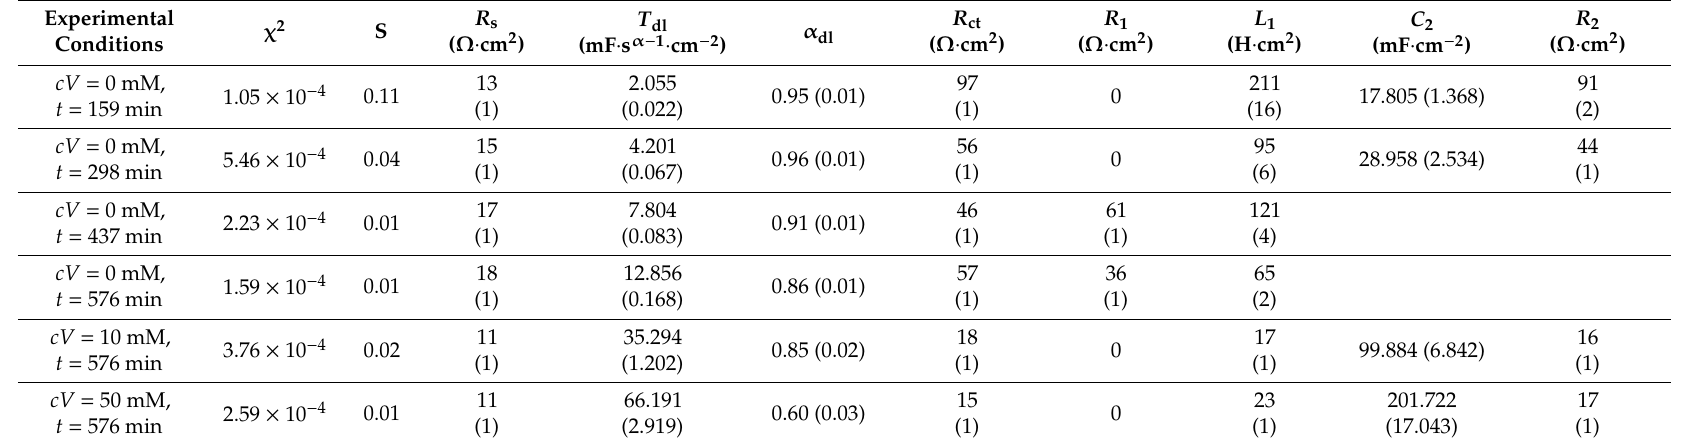
Table 3. The results of fitting of the impedance spectra obtained at pH = 1.3 using EEC from Figure 11a,c: χ 2 and S indicate the quality of the fit (chi-square and residual sum of squares, respectively); R s is the solution resistance; T dl is the parameter of the constant phase element CPE dl representing the electrical double layer; α dl is the exponent of the CPE; R ct is the charge-transfer resistance; L 1 , R 1 , R 2 , and C 2 are the inductance, resistances, and capacitance related to the adsorption processes, respectively, uncertainties of the fitted parameters are given in brackets.